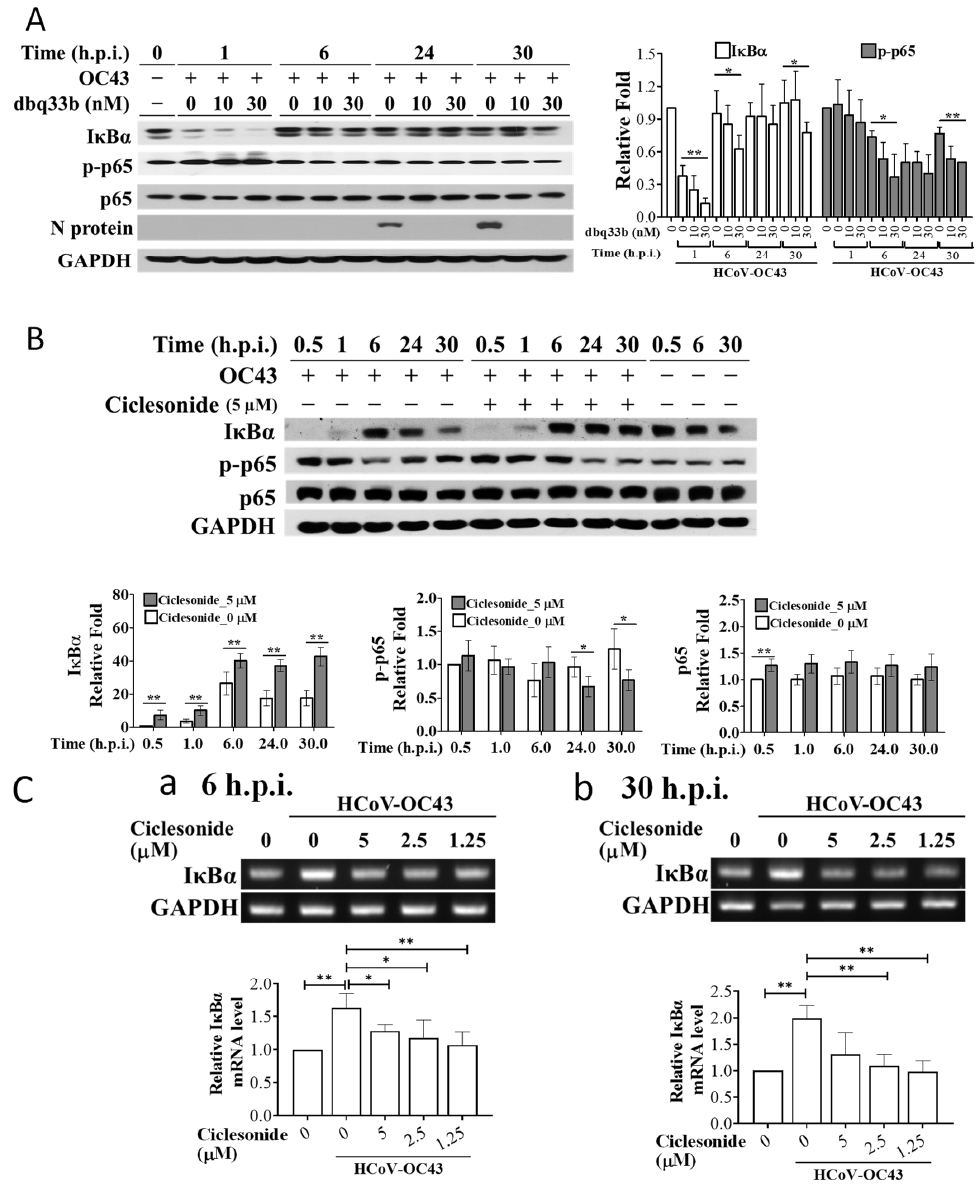
Figure 2. The effects of tylophorine-based dbq33b and ciclesonide on I κ B α protein levels in HCoV- OC43-infected fetal lung fibroblast MRC-5 cells. ( A ) Effects of tylophorine-based dbq33b on the I κ B α protein levels in HCoV-OC43-infected MRC-5 cells over a period of 30 h. ( B ) Ciclesonide treatment increased I κ B α protein levels in HCoV-OC43-infected MRC-5 cells over a period of 30 h. ( C ) Ciclesonide decreased transcriptional levels of I κ B α at 6 h.p.i. ( a ) and 30 h.p.i. ( b ). Uninfected and HCoV-OC43-infected (MOI: 0.05) MRC-5 cells treated with tylophorine-based dbq33b or ciclesonide (5 μ M pretreatment for 1 h) were harvested at the indicated h.p.i. The resulting lysates were sub- jected to western analyses with the antibodies indicated (A and B). For transcriptional analyses, the uninfected and HCoV-OC43-infected (MOI: 0.05) MRC-5 cells treated with different concentrations of ciclesonide (0, 1.25, 2.5, 5 μ M pretreatment for 1 h) were, respectively, harvested at 6 h.p.i. and 30 h.p.i. The TRIzol™ Reagent (Invitrogen, 15596018) was used to extract total RNA from the resultant cell lysates prior to performing RT-PCR using the specific primer pairs for the genes indicated. ( C ) Results shown are representative of three independent experiments and AVE ± S.D. from three in- dependent experiments. (* p < 0.05, ** p < 0.01 for student’s t -test).